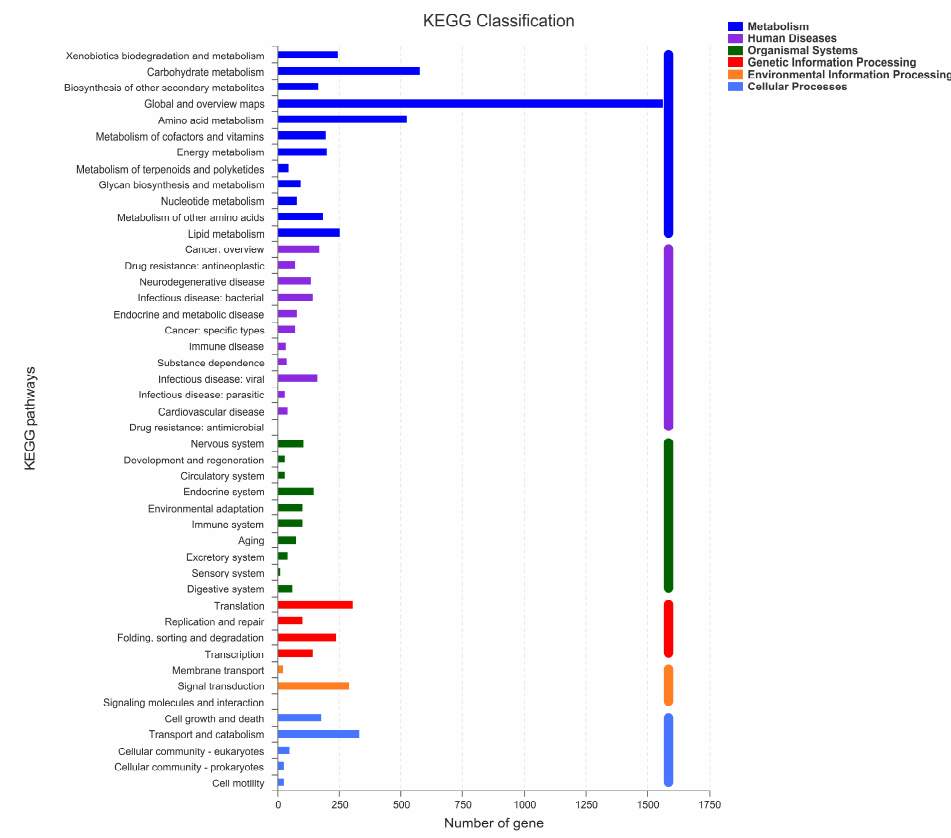
Figure 5. Kyoto Encyclopedia of Genes and Genomes (KEGG) analysis of D. alcacerensis CT-6 genes encoding the proteins.